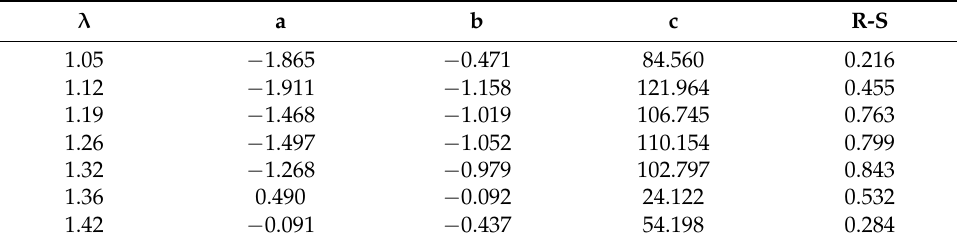
Table 10. Fitting parameters of CA90-CA50 and PMAX distribution under different λ .